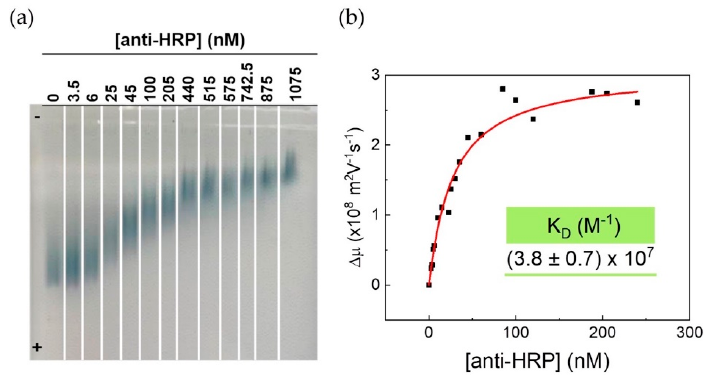
Figure 4. AGE of AuNS–MBA with increasing molar ratios of anti-HRP. ( a ) Exemplary 0.3% agarose gel for concentrations of anti-HRP from 3.5 to 1075 nM corresponding to [anti-HRP] to [AuNS–MBA] ratios from 7 to 2150. ( b ) Variation of electrophoretic mobility ( Δ µ) vs. anti-HRP concentration of the various AuNS–MBA-anti-HRP conjugates. Data was fitted to an adsorption isotherm of the Hill type with parameters Δ µ max = (3.1 ± 0.2) × 10 − 8 m 2 V − 1 s − 1 K D = (38 ± 7) nM, n = 1.0 ± 0.1, and adjusted R 2 = 98%. Electrophoretic mobility is normalized for the maximum mobility, corresponding to the sample without the antibody. Data presented in the graph is derived from three different AGE, with each using a different set of anti-HRP concentration values.